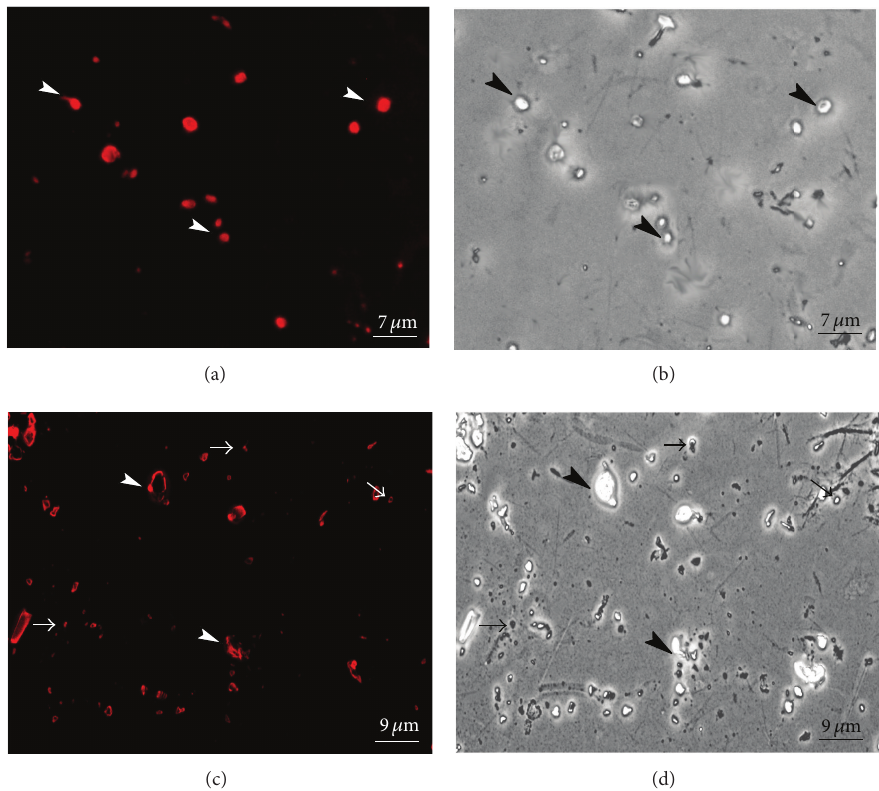
Figure 7: Photomicrography of reconstituted liposomes before ((a) and (b)) challenged with FOSC ((c) and (d)). Liposomes were identified by Rhodamin B labeled probe ((a) and (c)) and phase contrast ((b) and (d)). The arrows are explained in the